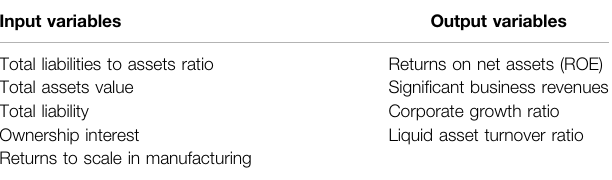
TABLE 1 | List of variables. TABLE 2 | Robustness test results using GMM panel data